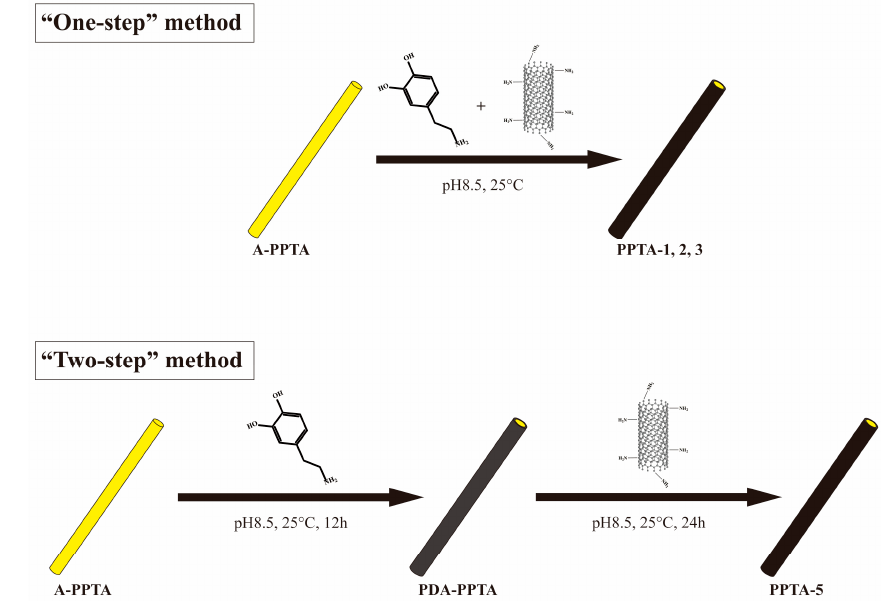
Figure 1. Schematic diagrams of surface modification.